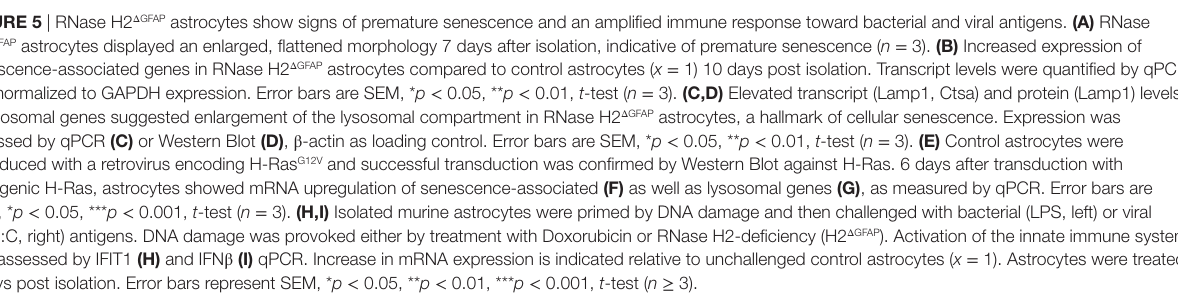
FigUre 5 | RNase H2 Δ GFAP astrocytes show signs of premature senescence and an amplified immune response toward bacterial and viral antigens. (a) RNase H2 Δ GFAP astrocytes displayed an enlarged, flattened morphology 7 days after isolation, indicative of premature senescence ( n = 3). (B) Increased expression of senescence-associated genes in RNase H2 Δ GFAP astrocytes compared to control astrocytes ( x = 1) 10 days post isolation. Transcript levels were quantified by qPCR and normalized to GAPDH expression. Error bars are SEM, * p < 0.05, ** p < 0.01, t -test ( n = 3). (c,D) Elevated transcript (Lamp1, Ctsa) and protein (Lamp1) levels of lysosomal genes suggested enlargement of the lysosomal compartment in RNase H2 Δ GFAP astrocytes, a hallmark of cellular senescence. Expression was assessed by qPCR (c) or Western Blot (D) , β -actin as loading control. Error bars are SEM, * p < 0.05, ** p < 0.01, t -test ( n = 3). (e) Control astrocytes were transduced with a retrovirus encoding H-Ras G12V and successful transduction was confirmed by Western Blot against H-Ras. 6 days after transduction with oncogenic H-Ras, astrocytes showed mRNA upregulation of senescence-associated (F) as well as lysosomal genes (g) , as measured by qPCR. Error bars are SEM, * p < 0.05, *** p < 0.001, t -test ( n = 3). (h,i) Isolated murine astrocytes were primed by DNA damage and then challenged with bacterial (LPS, left) or viral (polyI:C, right) antigens. DNA damage was provoked either by treatment with Doxorubicin or RNase H2-deficiency (H2 Δ GFAP ). Activation of the innate immune system was assessed by IFIT1 (h) and IFN β (i) qPCR. Increase in mRNA expression is indicated relative to unchallenged control astrocytes ( x = 1). Astrocytes were treated 7 days post isolation. Error bars represent SEM, * p < 0.05, ** p < 0.01, *** p < 0.001, t -test ( n ≥